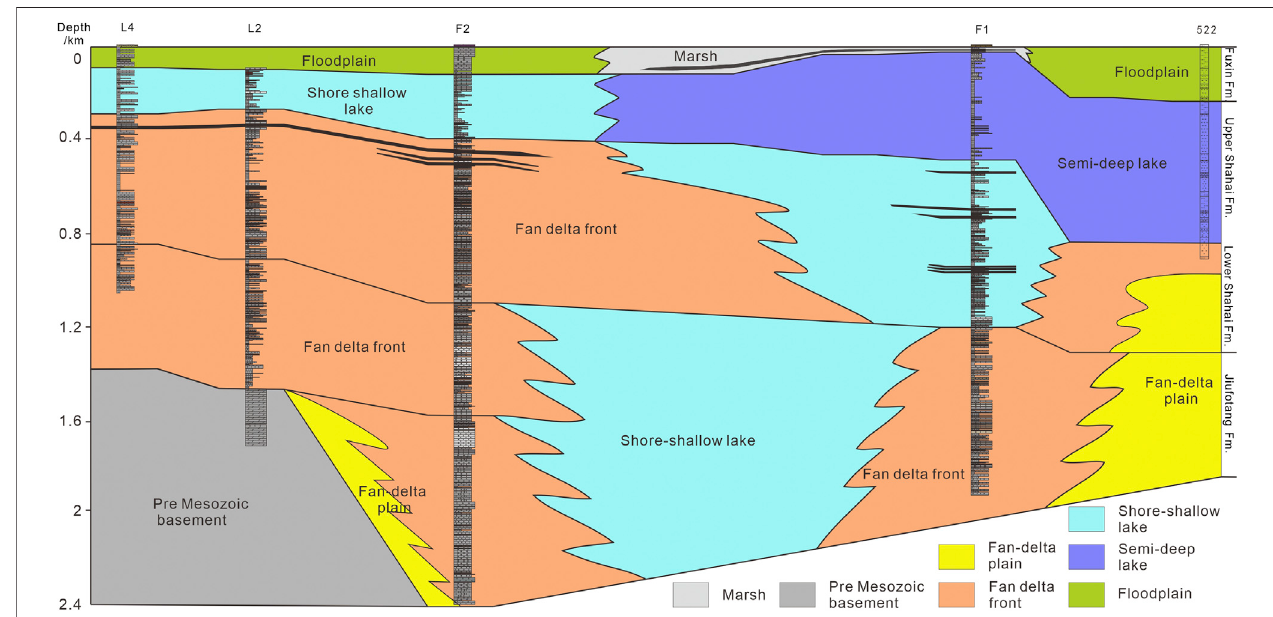
FIGURE 9 | Sedimentary section compiled from borehole data from the Fuxin Basin, showing the vertical variation in the sedimentary facies.